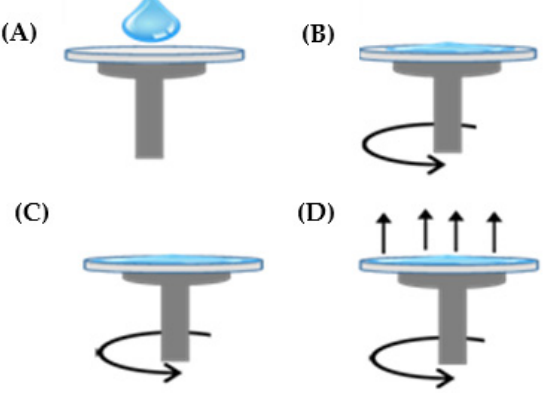
Figure 2. Spin coat process of ( A ) deposition, ( B ) initial spin, ( C ) final spin, and ( D ) evaporation.